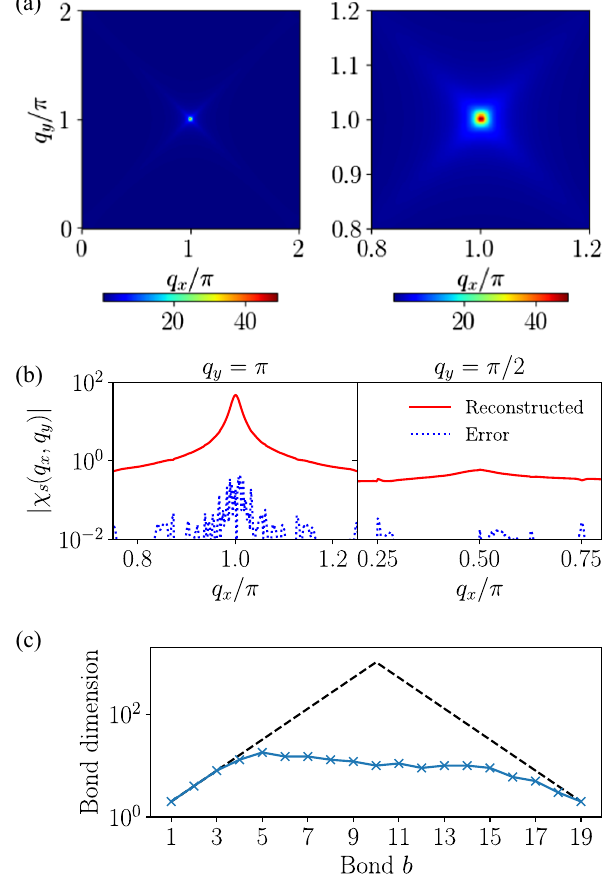
FIG. 12. (a) Spin susceptibility of the 2D Hubbard model at zero frequency and an enlarged plot. (b) Reconstructed data and π and q π = 2 . (c) Bond dimensions of the MPS. error at q y ¼ y ¼ The dashed line indicates the maximum bond dimensions in maximally entangled cases. The compression ratio is